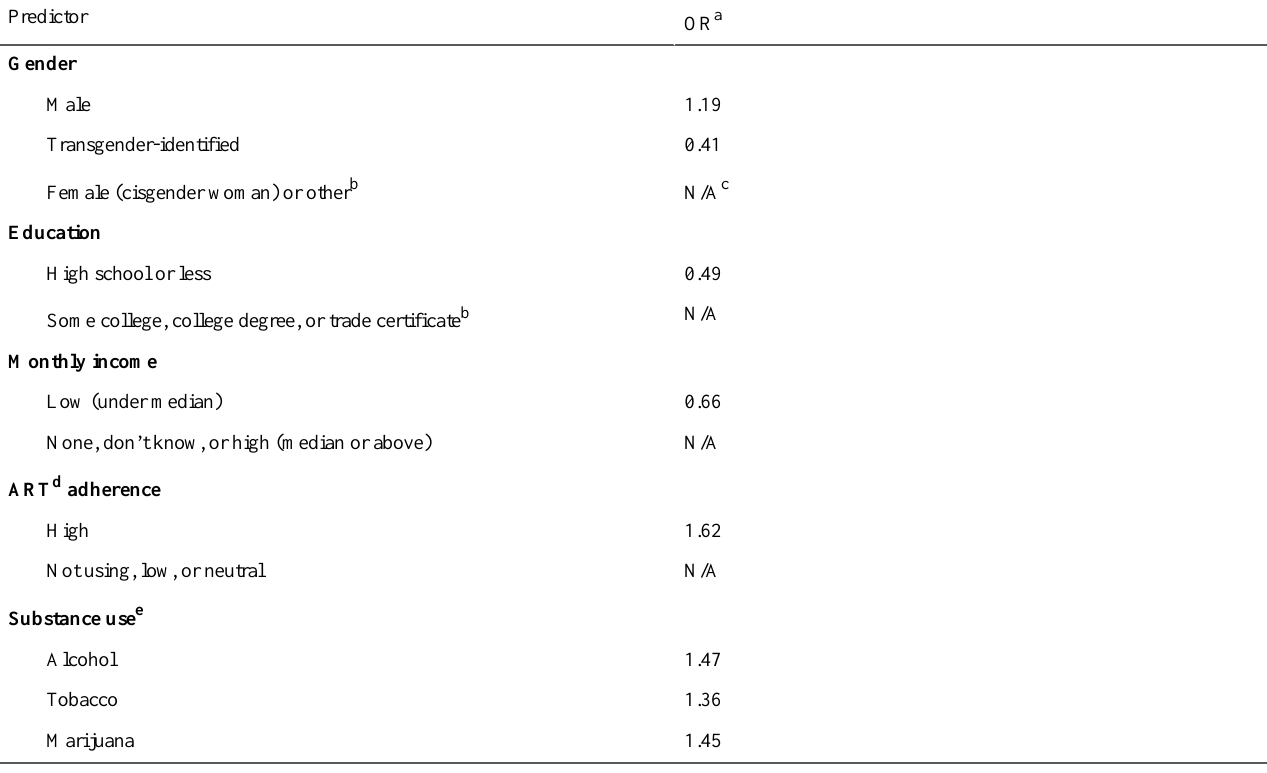
Table 3. Odds ratios from logistic regressions of general health information seeking through the internet over the past 6 months. Predictors were selected by lasso regression